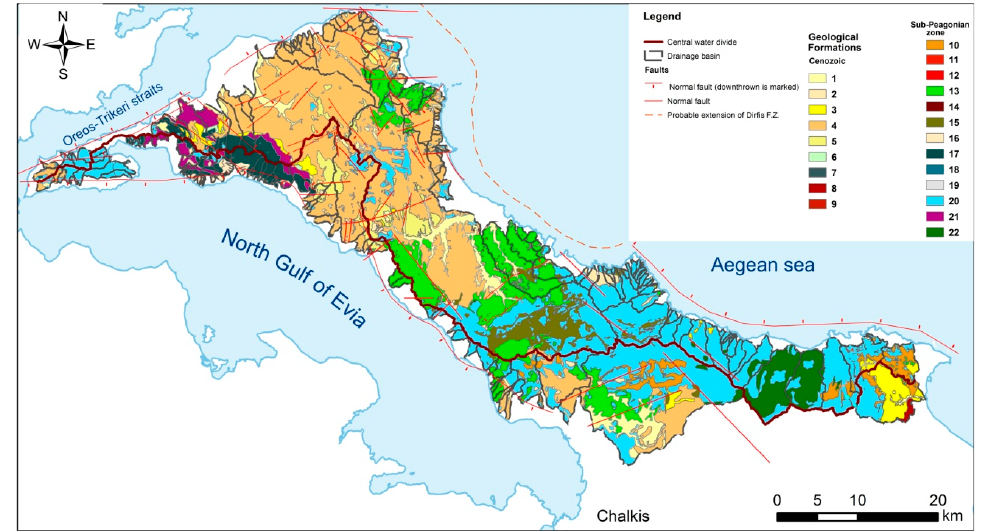
Figure 2. Simplified geological map and outline of the drainage basins of the study area based on the geological map of Greece published by the Institute of Geology and Mineral Exploration of Greece (IGME) [33] ( 1 : alluvial deposits (Quaternary), 2 : recent talus cones (Quaternary), 3 : Neogene sediments (Neogene), 4 : marl (Neogene), 5 : conglomerate (Neogene), 6 : olistolith (Neogene), 7 : andesite (Neogene), 8 : lavas (Neogene), 9 : magnesite deposits (Paleogene), 10 : flysch (Upper Cretaceous), 11 : iron-nickel ore (Upper Cretaceous), 12 : bauxite (Upper Cretaceous), 13 : ophiolite (Upper Jurassic–Lower Cretaceous), 14 : chert (Upper Jurassic–Lower Cretaceous), 15 : schist-chert (Upper Jurassic–Lower Cretaceous), 16 : talus cones (Middle Triassic), 17 : greywacke (Triassic), 18 : diabase (Meosozoic), 19 : tuff (Permian), 20 :